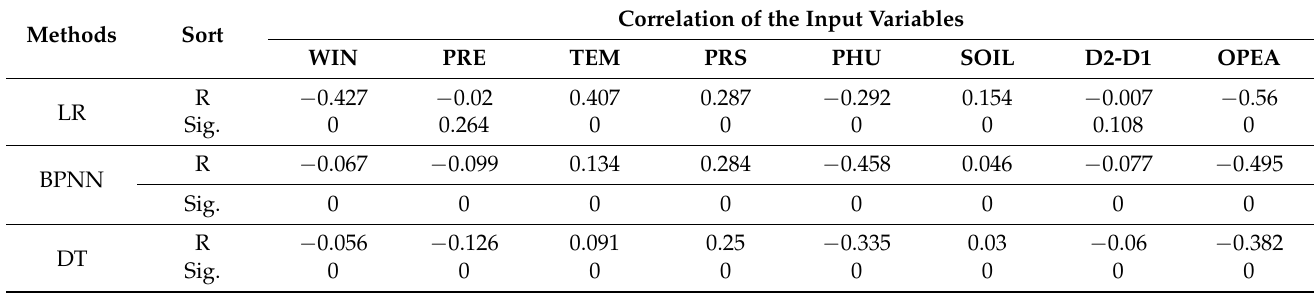
Table 4. Relationship of input data and agricultural fire forecasting factors in all three